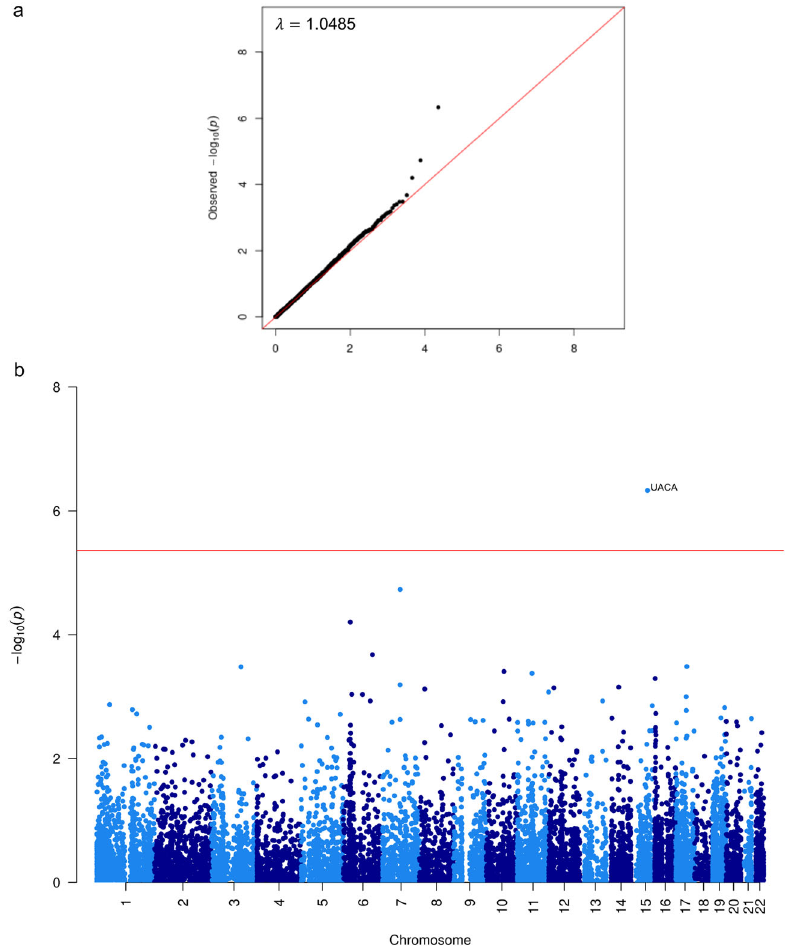
Fig. 8 QQ plot and Manhattan plot for TWAS of OS in the Pathways European population when including only patients taking Par-4 dependent chemotherapies. a QQplot. b Manhattan plot. The red line in the Manhattan plot corresponds to transcriptome-wide signi fi cance (4.34 × 10 − 6 ) after multiple hypothesis correction for 11,520